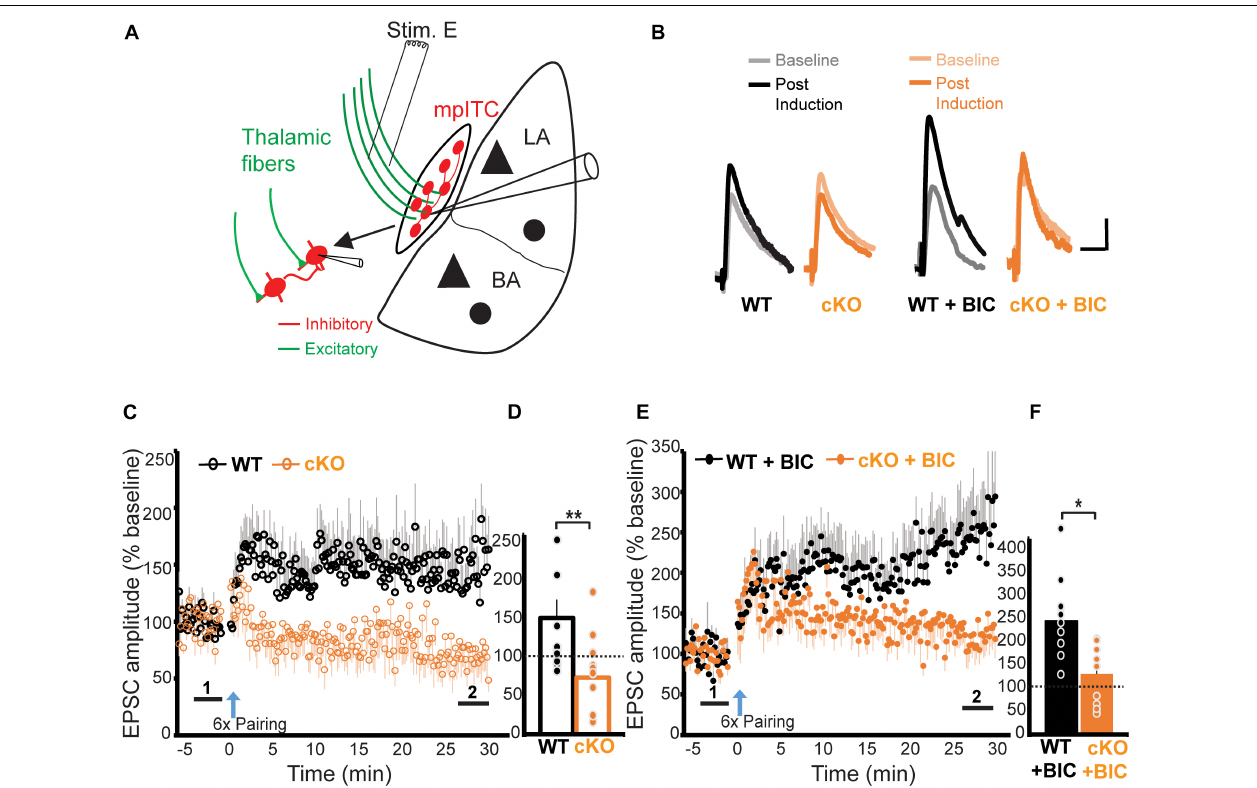
FIGURE 4 | ErbB4 deletion impairs LTP of thalamic inputs to mpITCs. (A) A schematic diagram showing the placement of the stimulating electrode in the internal capsule to recruit thalamic fibers, while recording synaptic responses in mpITCs. (B) Sample traces of baseline (light) and post-induction (dark) EPSPs. Scale bars represent 3 mV, 30 ms. (C) Summary data showing that ErbB4 suppresses LTP of thalamic inputs to mpITCs in drug-free ACSF. (D) Quantification of (C) . Mean post-induction EPSP amplitude is decreased in cKO mice compared to WT mice in drug-free condition. WT vs. cKO, p = 0.008; cKO experienced long-term depression after induction (cKO vs. baseline, p = 0.032). Experimental groups: WT, n = 10; cKO; n = 10. WT 146.0 ± 23.0%, cKO 71.2 ± 13.0%; (E) Summary data showing ErbB4 suppression of LTP of thalamic inputs to mpITCs in the presence of inhibition blocker (bicuculline, BIC) in ACSF. (F) Quantification of (E) . Mean post-induction EPSP amplitude is decreased in cKO + BIC mice compared to WT + BIC mice in the presence of 20 µ M BIC (WT + BIC vs. cKO + BIC, p = 0.010). Experimental groups: WT + BIC, n = 10; cKO + BIC; n = 11. WT + BIC 232.0 ± 37.4%, cKO + BIC 123.5 ± 17.7%. Mean data in (D,F) are averages of the last 3 min of post-induction recordings denoted by “2” in (C,E) . Dash line represents normalized baseline (1). * p < 0.05; ** p <